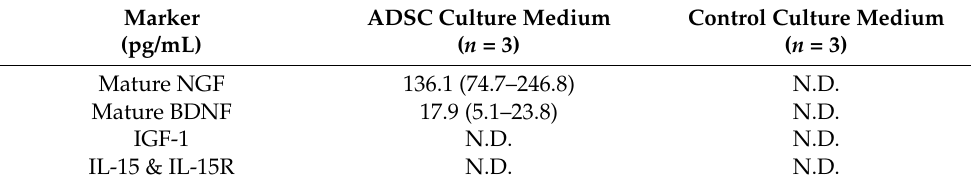
Figure 4. Immunohistochemical analysis of paired box 6 in the upper-middle region of the nasal septum (Part 1) of mice 24 h, 3 d, and 7 d after left side nasal administration of ADSCs. ( A ) Representative images of immunohistochemical staining of paired box 6 (PAX6). ( B , C ) Number of positive cells with PAX6 in the upper-middle region of the nasal septum of mice. ( B ) Left side. ( C ) Right side. Images are representative of five mice for each treatment group. Bars = 100 µ m. Statistical significance was determined by the Mann–Whitney test. * p < 0.05. Table 4. Quantification of neurotrophic factors in ADSC culture supernatant with ELISA.